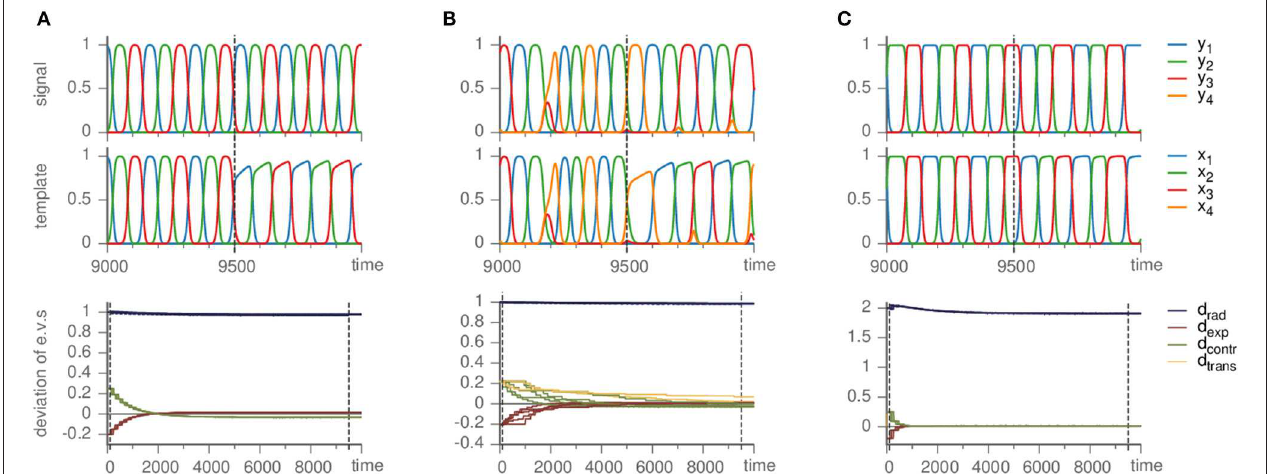
FIGURE 5 | Effects of mismatched templates. Upper panels show the dynamics of the signal and template against time. Lower panels display the deviation of the eigenvalue in the template from their value a i , j m in the master system, i.e., d i , j contracting, and transverse). Parameters are ϑ second-order terms, using ρ